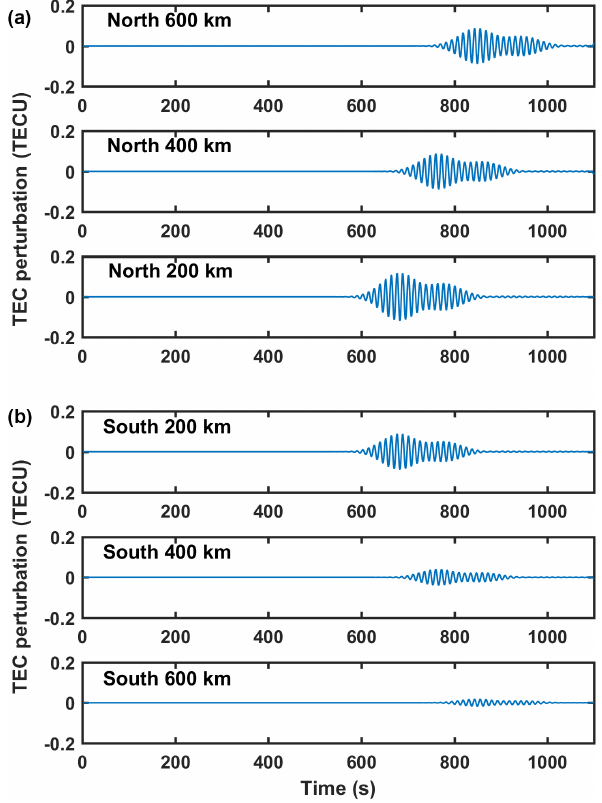
Figure 9. TEC perturbations in the SAMI2 model over six different locations along north–south direction about the epicentre: (a) shows TEC perturbation amplitude in the north direction, while (b) shows it for the south direction. Note that the TEC perturbation amplitude reduces drastically in the south